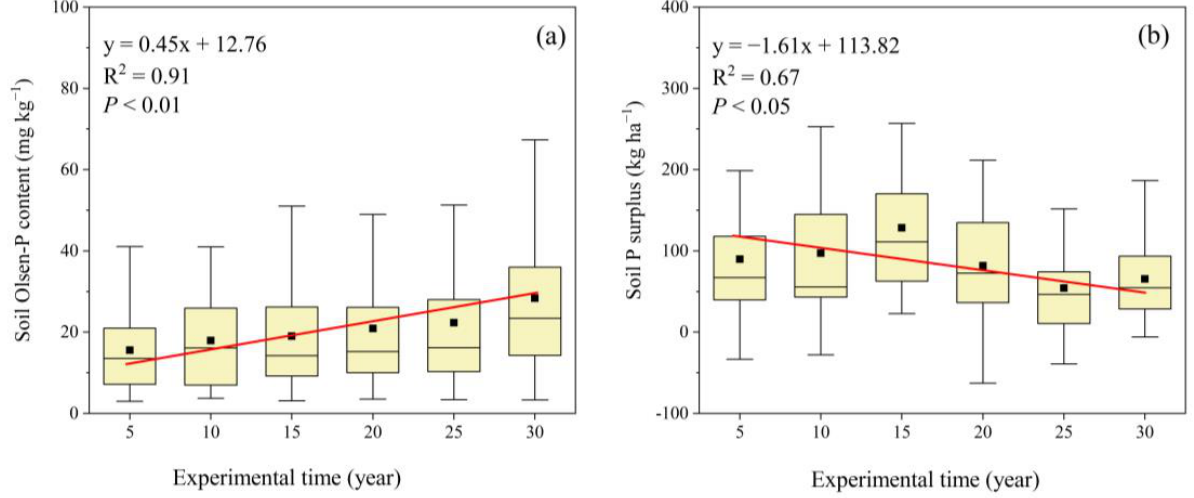
Figure 2. Soil Olsen-P content ( a ) and soil P surplus ( b ) over time under 91 long-term fertilization experiments from 1988 to 2018. The black line and dot, lower and upper edges and bars represent median and mean values, 25th and 75th, and 5th and 95th percentiles of all data, respectively. Probability levels < 0.05 were considered as statistically